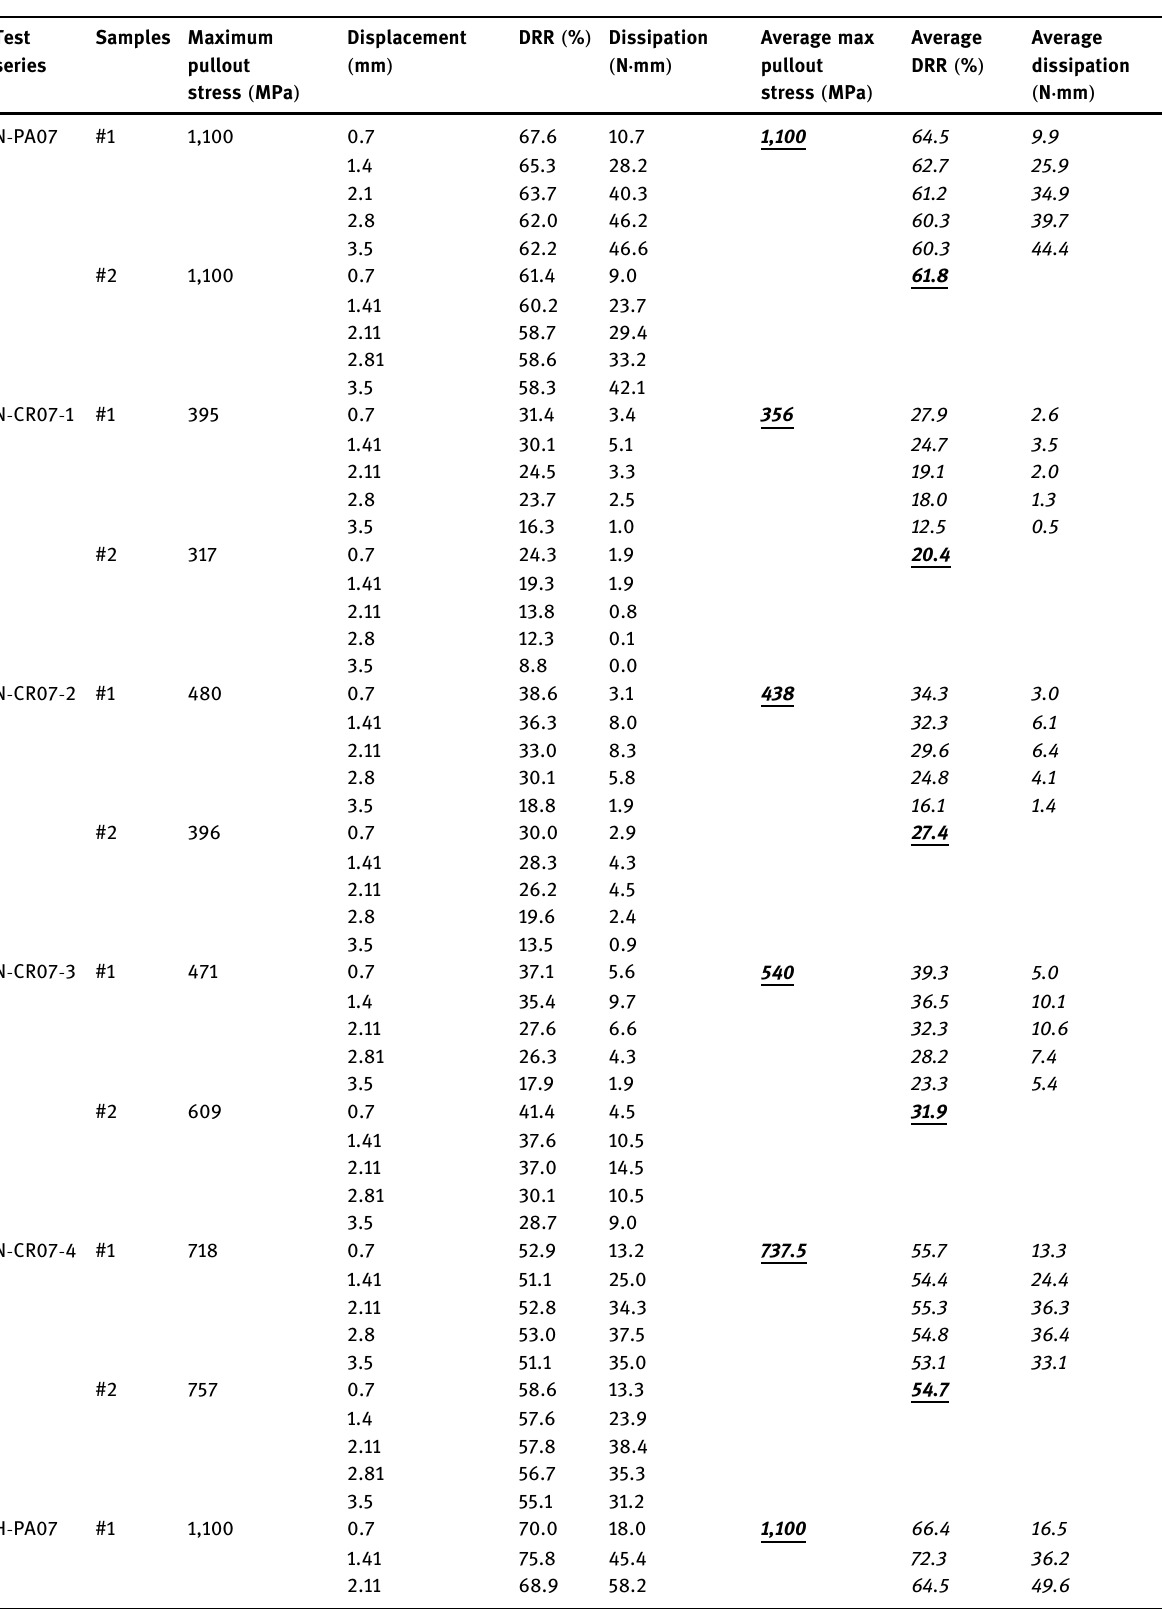
Table 3: Cyclic pullout parameters of crimped fi bers Test Samples series